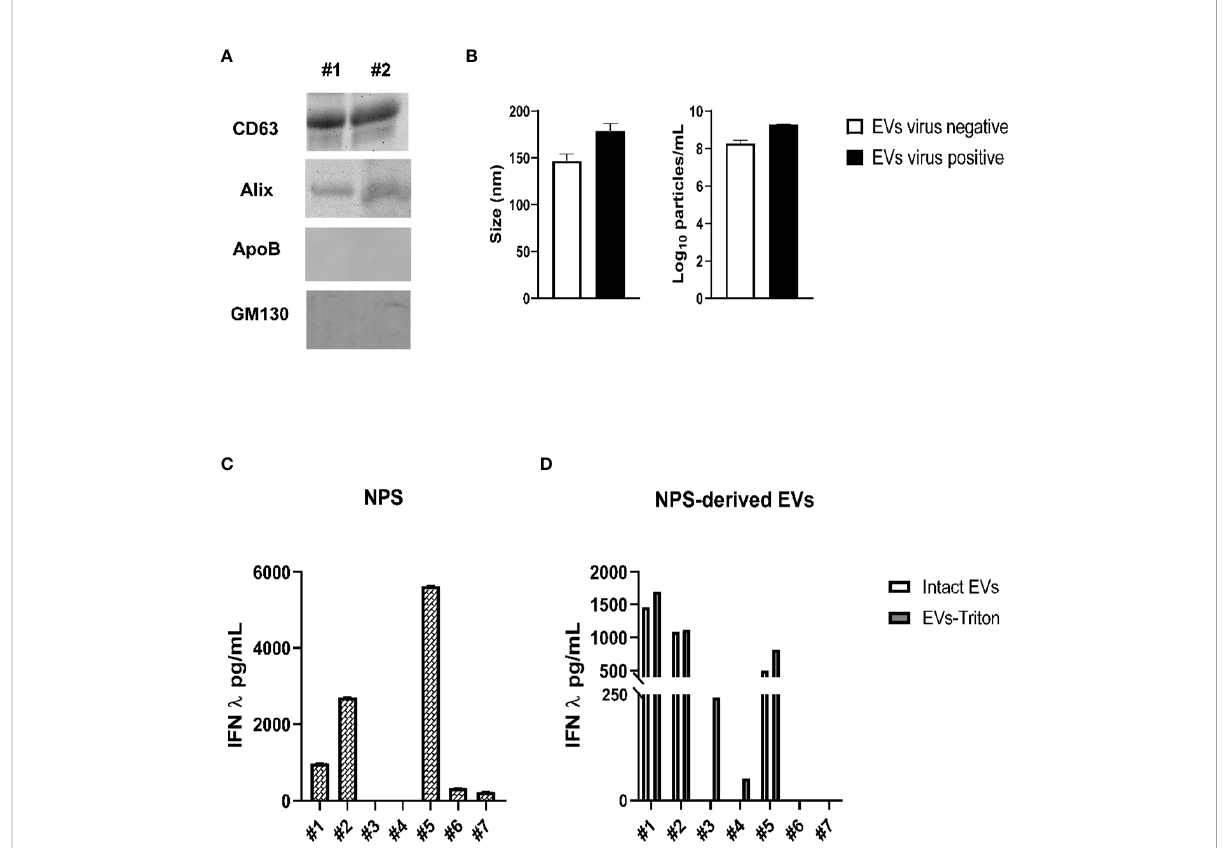
FIGURE 5 Characterization of NPS-derived EVs from children with and without viral infections. (A) Western blot analysis of equal amounts of puri fi ed EVs (5 m g) for CD63, Alix, ApoB and GM130. #1 and 2 indicates EV samples isolated from two representative patients. (B) Absolute size (left graph) and concentration (right graph) determined by Nanosight analysis of EVs isolated from virus negative (open bars) or virus positive (black bars) NPS. IFN- l concentrations were measured by ELISA in NPS samples (C) or NPS-derived EVs (D) of children with or without viral lower respiratory tract infections. Patients #1 and #2 = RSV; Patient #3 = SARS-CoV-2; Patients #4 and #5 = Rhinovirus (RV), Patients #6 and #7 =